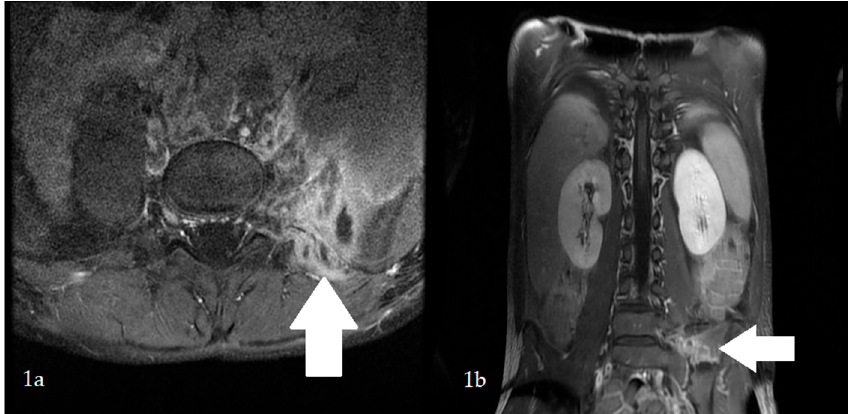
Figure 1. Magnetic resonance imaging (MRI) of the lumbosacral spine in the transverse ( 1a ) and longitudinal ( 1b ) position. Abscesses (marked with white arrows) of 10 × 18 mm occupying an area of 37 mm × 39 mm × 61 mm can be seen within the left iliopsoas muscle and paraspinal muscles at the L5-S1 level.